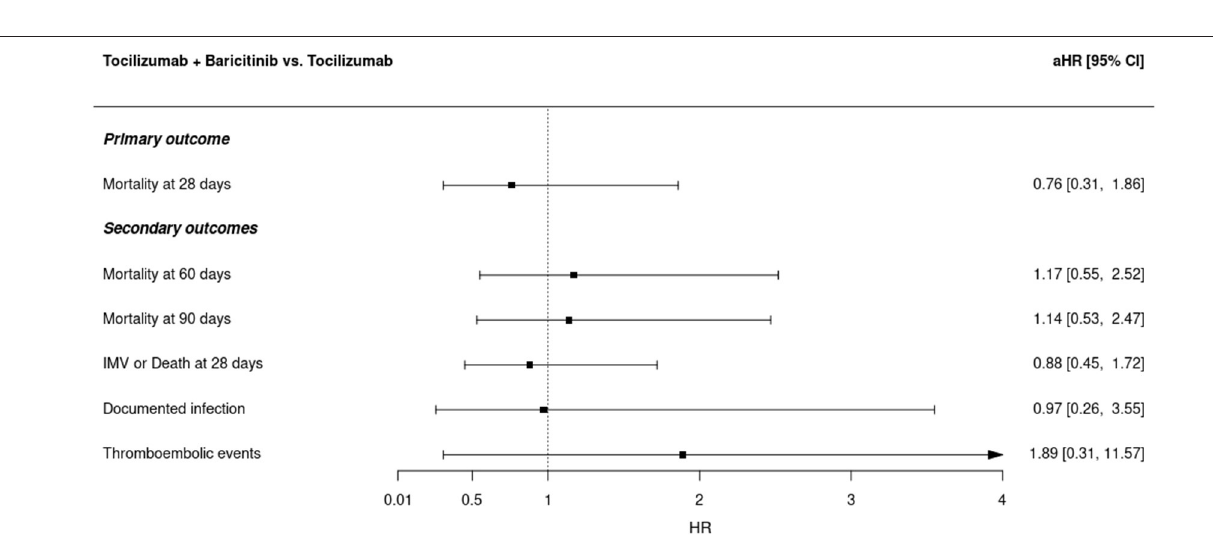
FIGURE 2 | Adjusted Cox regression model hazard ratios for the combination of tocilizumab plus baricitinib vs. tocilizumab alone in different study outcomes. Cox regression models were adjusted by sex, age, Charlson comorbidity index, WHO COVID-19 severity ordinal scale, the time-variant fraction of inspired oxygen, and remdesivir use. aHR, adjusted hazard ratio; IMV, invasive mechanical